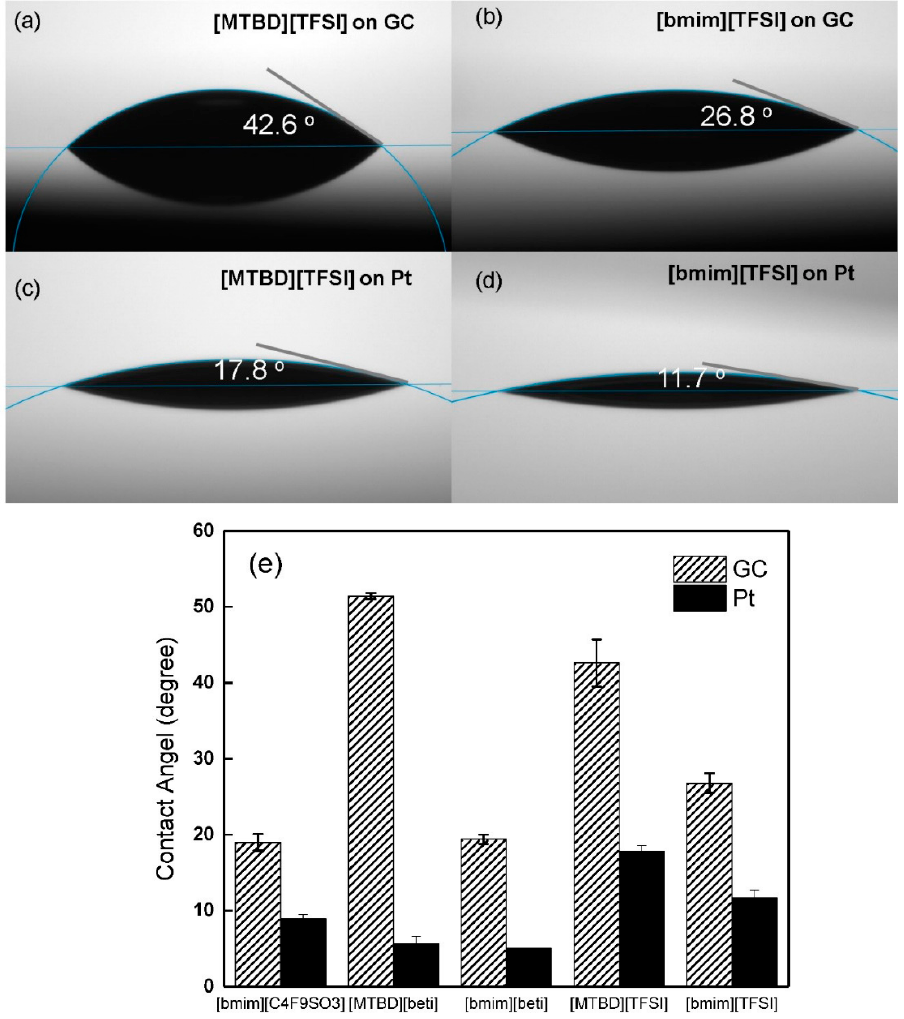
Figure 7. Contact angle measurements. ( a ) [MTBD][TFSI] on GC. ( b ) [bmim][TFSI] on GC. ( c ) [MTBD][TFSI] on Pt surface. ( d ) [bmim][TFSI] on Pt surface. ( e ) comparison of measured contact angles of all ILs except [MTBD][C 4 F 9 SO 3 ] which is solid at room temperature.